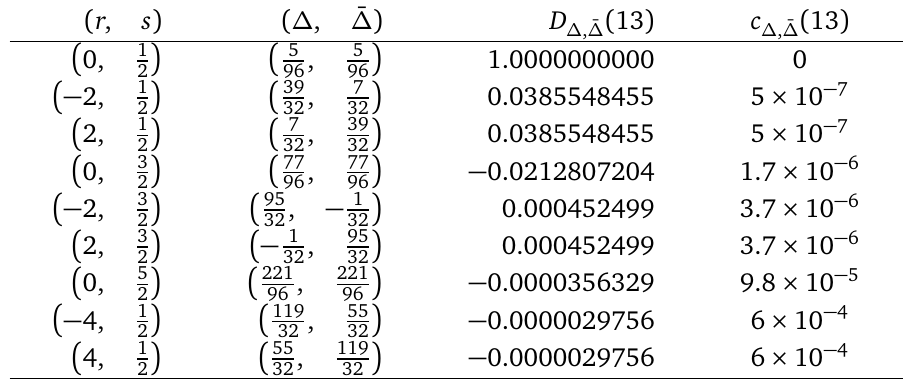
Table 9: Truncating the spectrum (cid:83) for the first 9 states